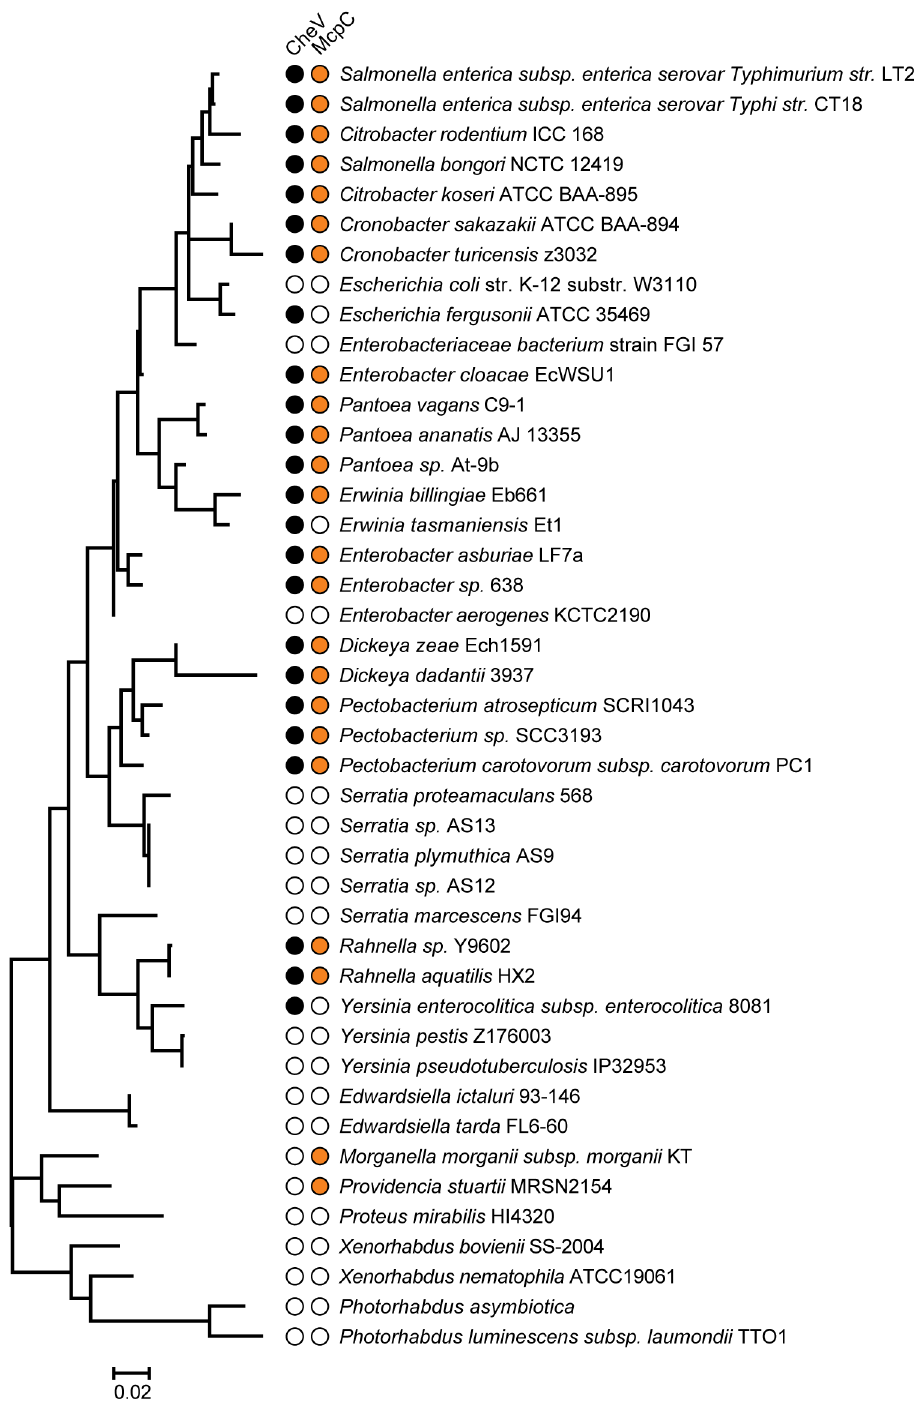
Fig 4. Co-Evolution of CheV and McpC orthologs. Phylogenetic profile shows the correlation of presence and absence of CheV (orange) and McpC orthologs (black). Left, 16S phylogenetic tree of the organisms used in this